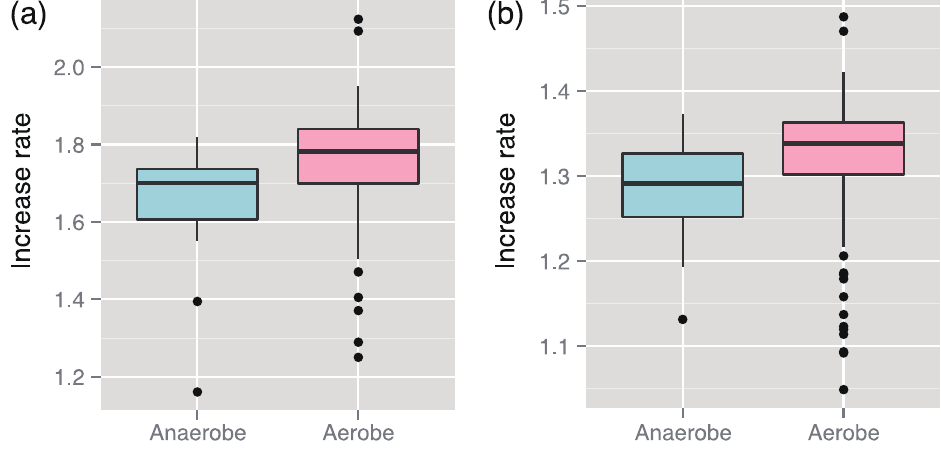
Figure 1. Median comparison of the increase rates between aerobes and anaerobes.